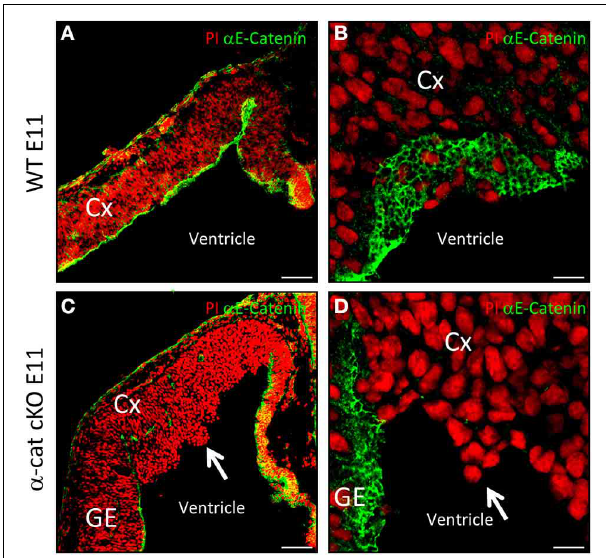
FIGURE 1 | Cortical development upon loss of α -catenin. α -E-catenin immunostaining (green, nuclei labeled with Propidium Iodide, red) in coronal sections of E11 WT (A,B) and α -cat cKO (C,D) cortices. Note the loss of α -E-catenin upon recombination by Emx1 Cre from E11 on, exclusively in the cortex, except in blood-vessels, the meninges, and the Choroid Plexus. Arrows indicates protrusions in the lateral ventricle. CX, cortex; GE, ganglionic eminence. Scale bars: 100 μ m (A,C) , 10 μ m (B,D) .